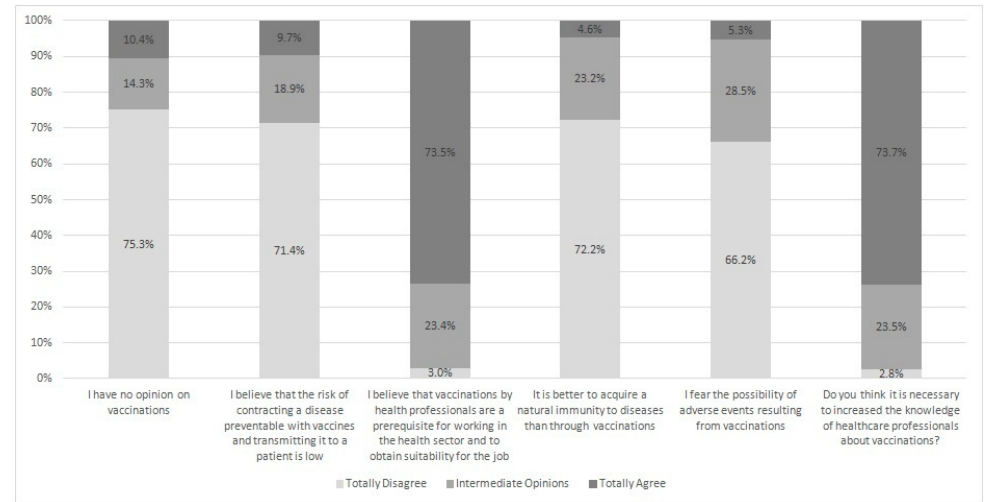
Figure 2. PHPs’ opinions (%) about vaccination practice.